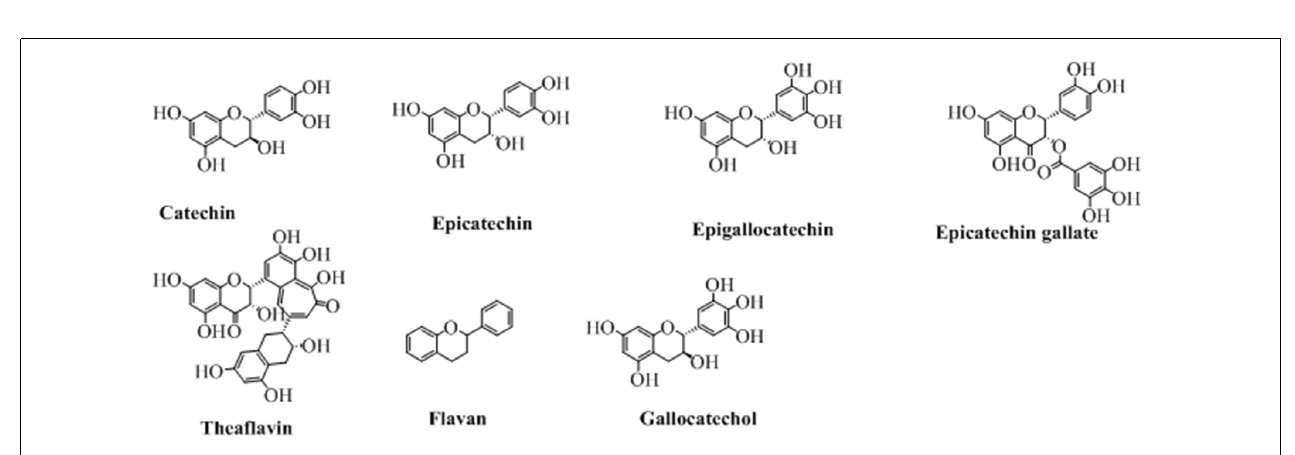
FIGURE 7 | The important members of the flavanonols class of flavonoids.